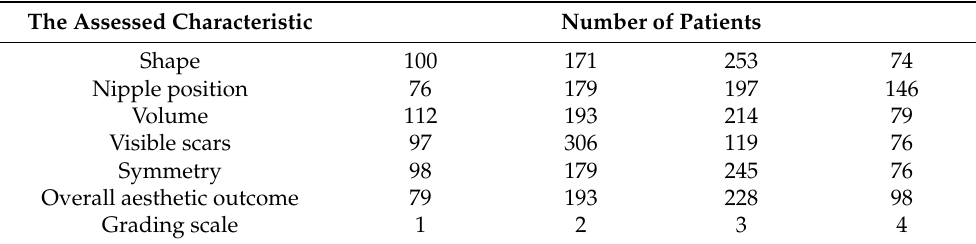
Table A7. The assessment of the outcomes of the operation completed by the doctors just before the surgery of the patients allocated in the control group.